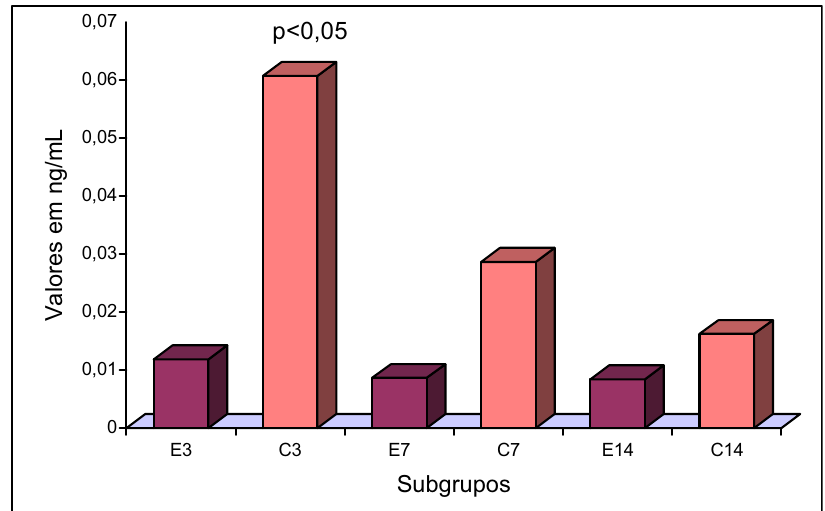
FIGURE 4 - TNF- α serum production in the experimental group (E3, E7 and E14) and in the control group (C3, C7 and C14)